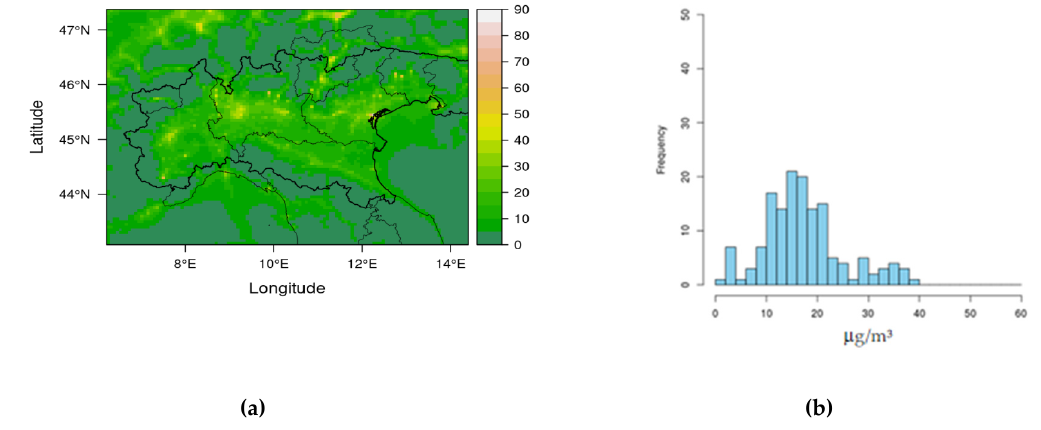
Figure 11. CLE2025 NO 2 : ( a ) ground field of annual average concentration ( μ g/m 3 ); ( b ) frequency distribution of annual average concentration in background stations.